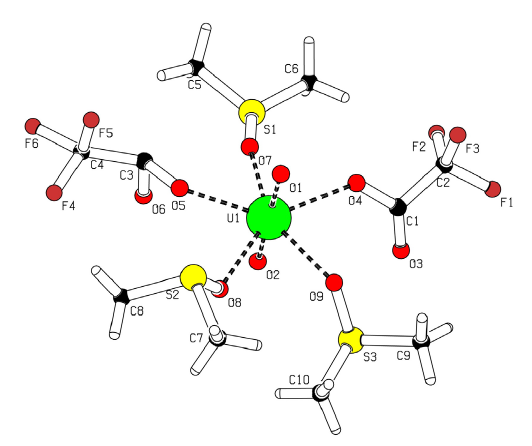
Fig. 1. Structural diagram of [UO